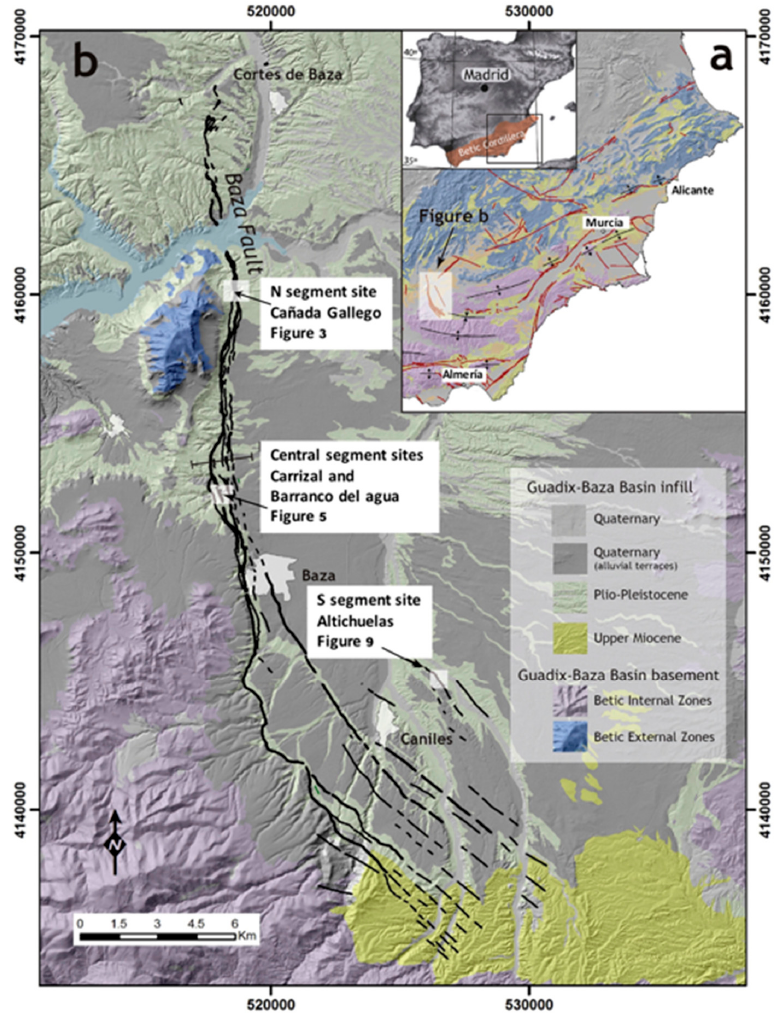
Figure 1. ( a ) Geological sketch map of the eastern part of the Betic Cordillera (legend as in Figure 1b). ( b ) General geological map of the Baza Fault. The studied sections belong to the Plio-Pleistocene Benamaurel Unit. Modified from Castro and collaborators [63].